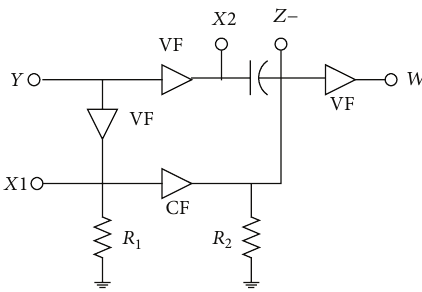
Figure 1: Basic scheme for all-pass section.